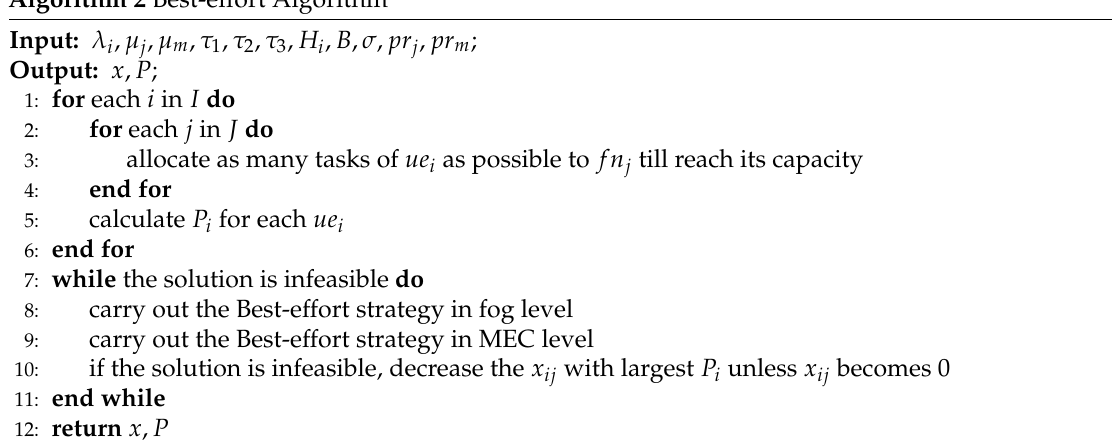
Algorithm 2 Best-effort